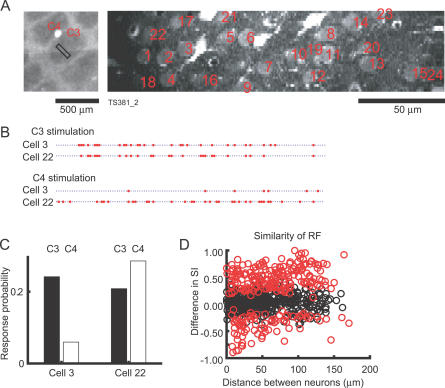
Heterogeneity of Response Selectivity(A) Left: the location of the imaged area in CO-stained barrels. Right: Fluo-4 AM image showing the locations of the analyzed cells.(B) The response pattern of two neighboring neurons (Cell 3 and Cell 22) to stimulation of whiskers C3 (the PW) and C4.(C) The response probability of Cell 3 and Cell 22 to C3 stimulation (black) and C4 stimulation (white).(D) The difference in SI for pairs of neurons as a function of the distance between the neurons. The distance was calculated as the projection of the position vector connecting pairs of neurons onto the line that connects the two neighboring barrels. Essentially indistinguishable data were obtained using the absolute distance (length of the position vector; see Figure S3). Red circles indicate pairs of neurons whose SIs were significantly different. RF, receptive field.